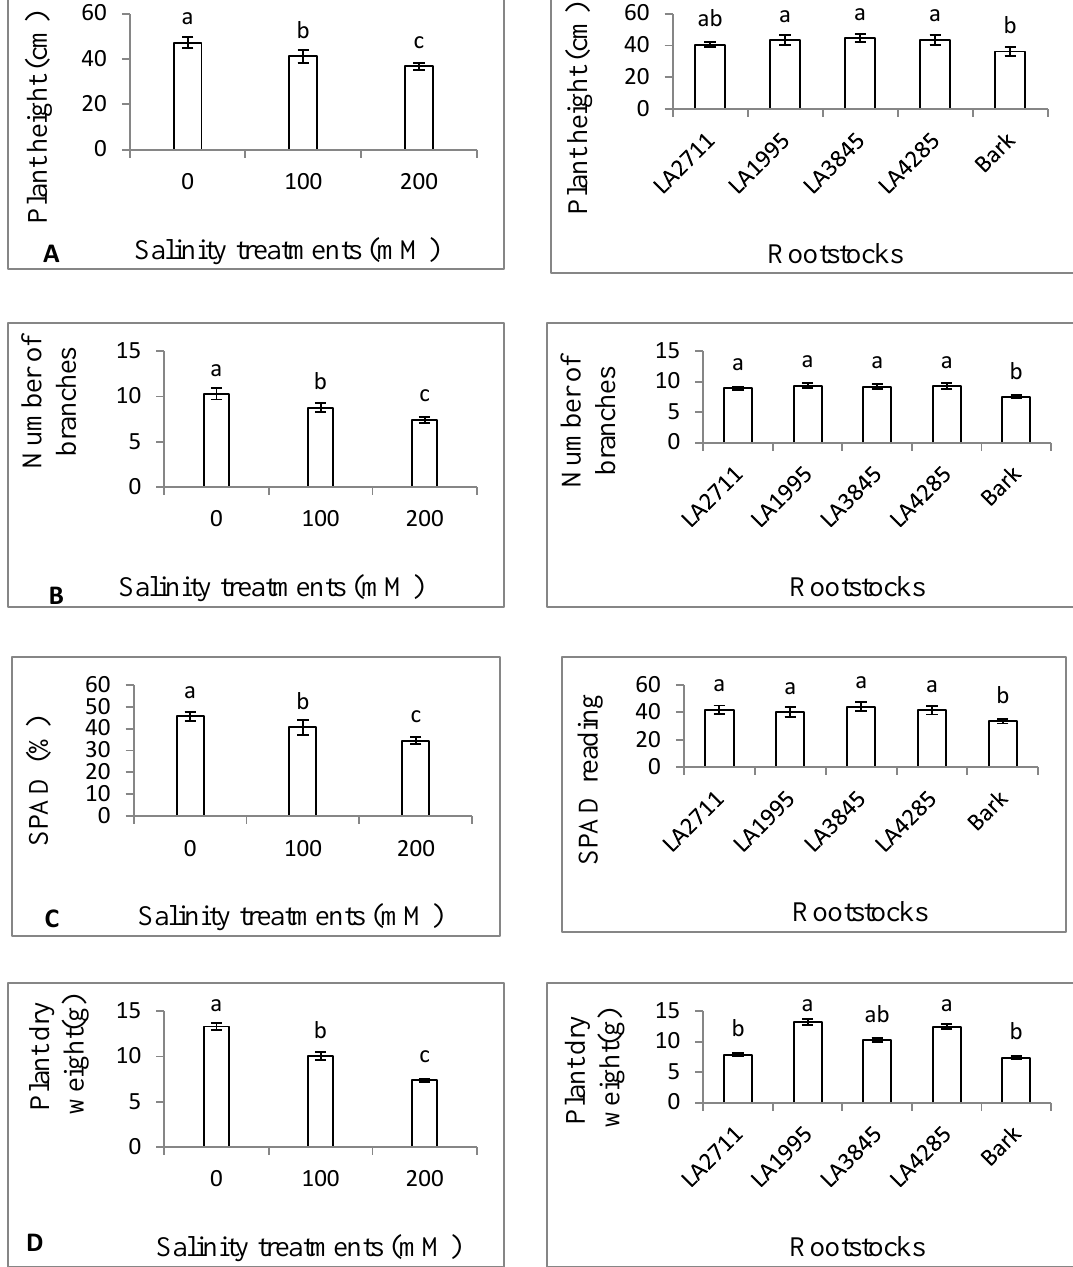
Figure 2. E ff ect of salt treatments and rootstocks on ( A ) plant height, ( B ) number of branches, ( C ) SPAD reading, and ( D ) plant dry weight. Di ff erent letters indicate significant di ff erences between treatments (Tukey test at p <